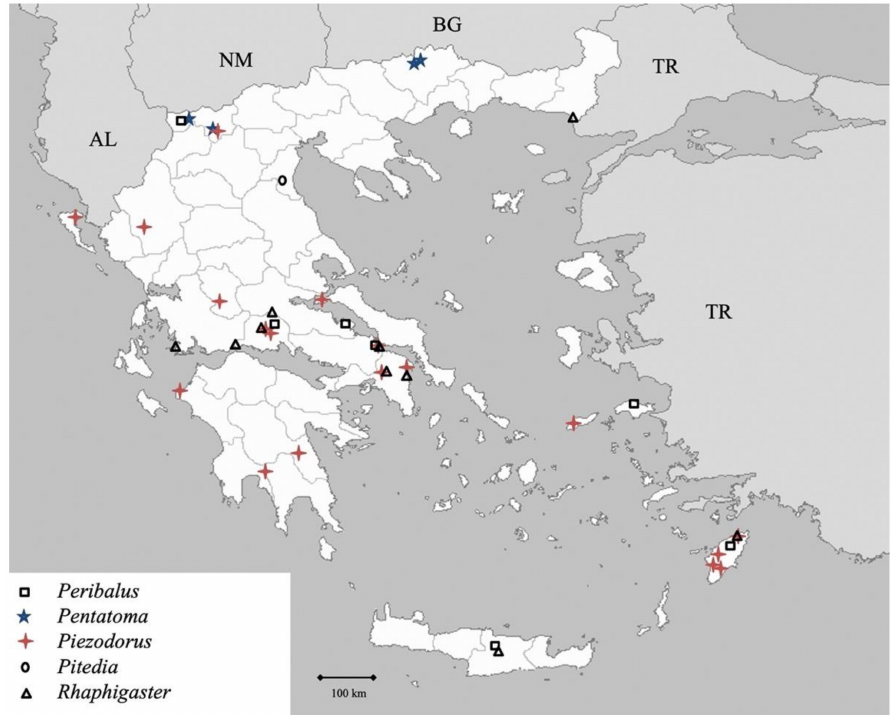
Figure 14. Map showing collecting sites of species of genera Peribalus, Pentatoma, Piezodorus, Pitedia and Rhaphigaster during the present study in